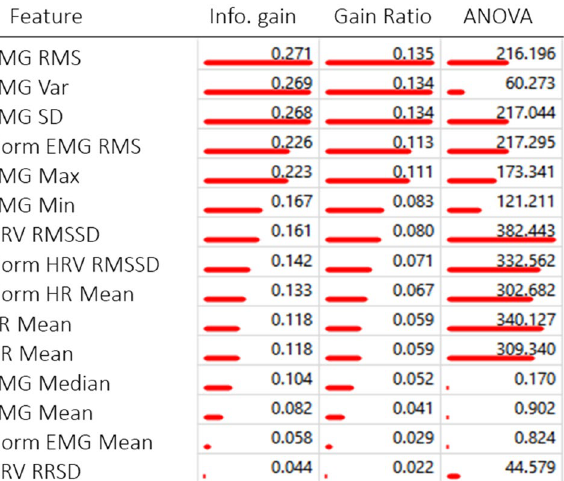
Table 4. Ranking of features in the dataset from overall most informative to least and ranking by each calculation; info gain, gain ration and ANOVA (redlines). Table produced using Orange (version 3.26) https:// orang edata mining.